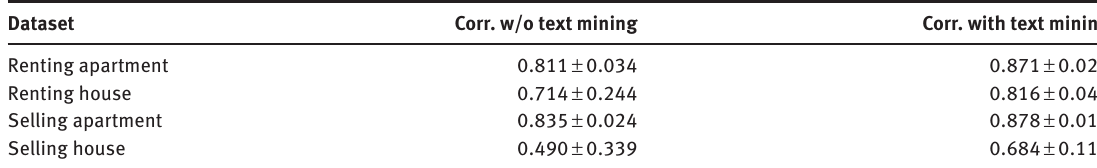
Table 6: Correlation (between Predicted and Actual Price) When ANN Regression Was Used in the First Stage of Our Two-Stage Regression Model.